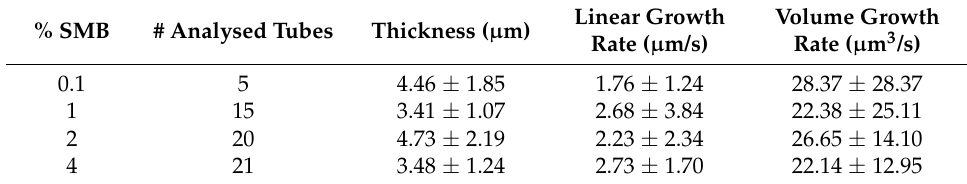
Figure 25. Microtubules formation and growth at 37 ◦ C. Air-water surfaces are shown in the tapered micropipette for a series of increasing SMB concentrations from 0 to 4 wt% in the Phospholipid (PL) mixture solution. Each meniscus is moved down the micropipette taper by increasing the micropipette pressure from 0.7, 1 and 2 kPa, to give the sequential surface compressions C1, C2 and C3, respectively. In each case, compressions were made, and images were obtained after a 10 min waiting period. The scale bar is 50 µ m. With permission from American Chemical Society [10]. Table 3. Diameters and linear and volumetric growth rates of the tubes in SMB + PL Samples. All the results are shown as the mean ± SD, calculated from all the tubes analysed for each composition. From